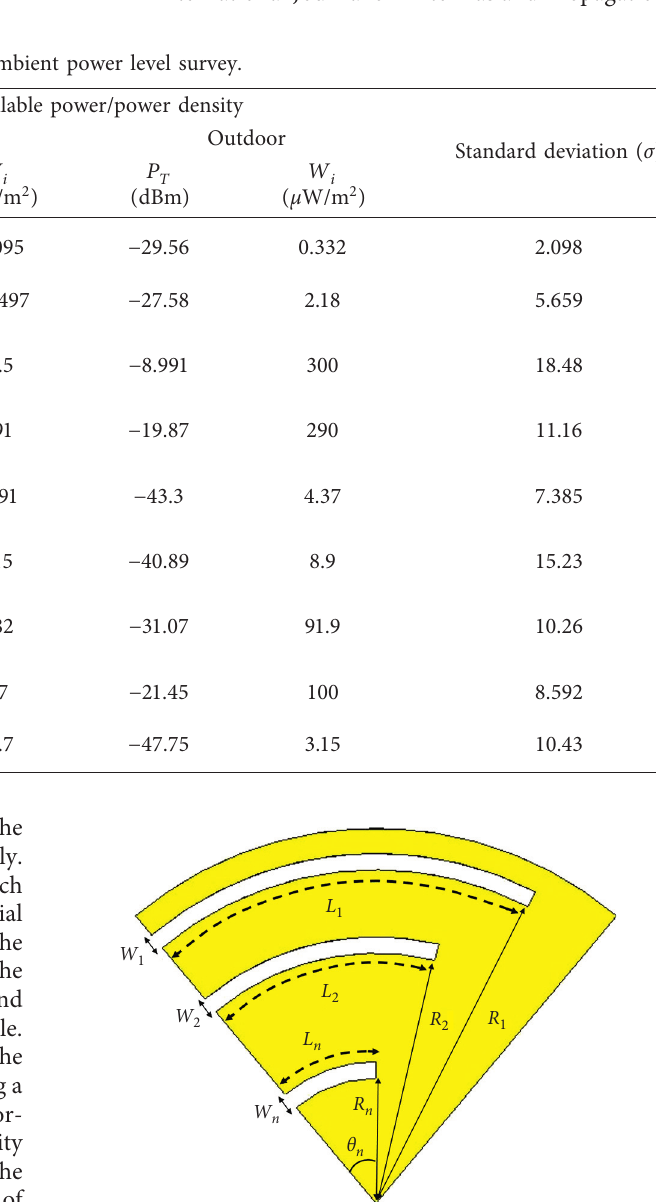
Figure 7: Slotted dipole